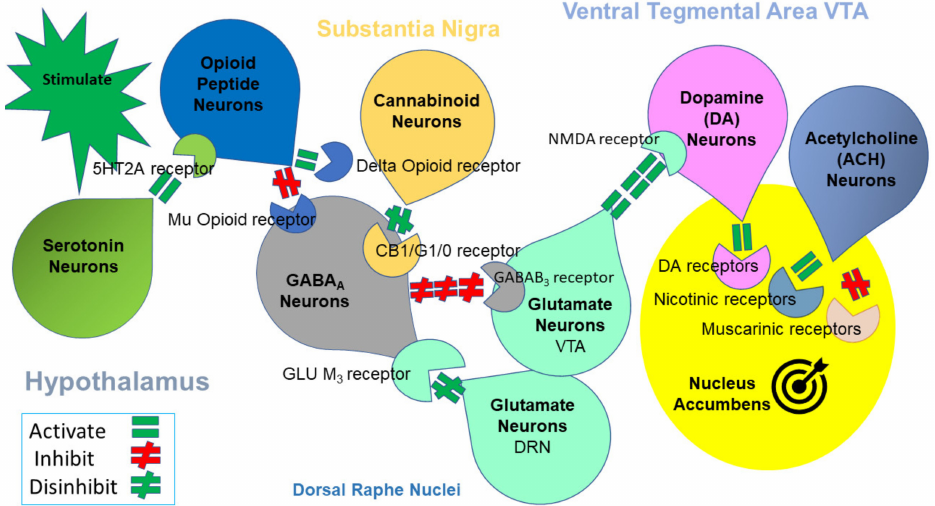
Figure 1. Precision Behavioral Management (PBM) platform. Reprinted/adapted with permission from Ref. [127]. Gold et al. copyright 2021.